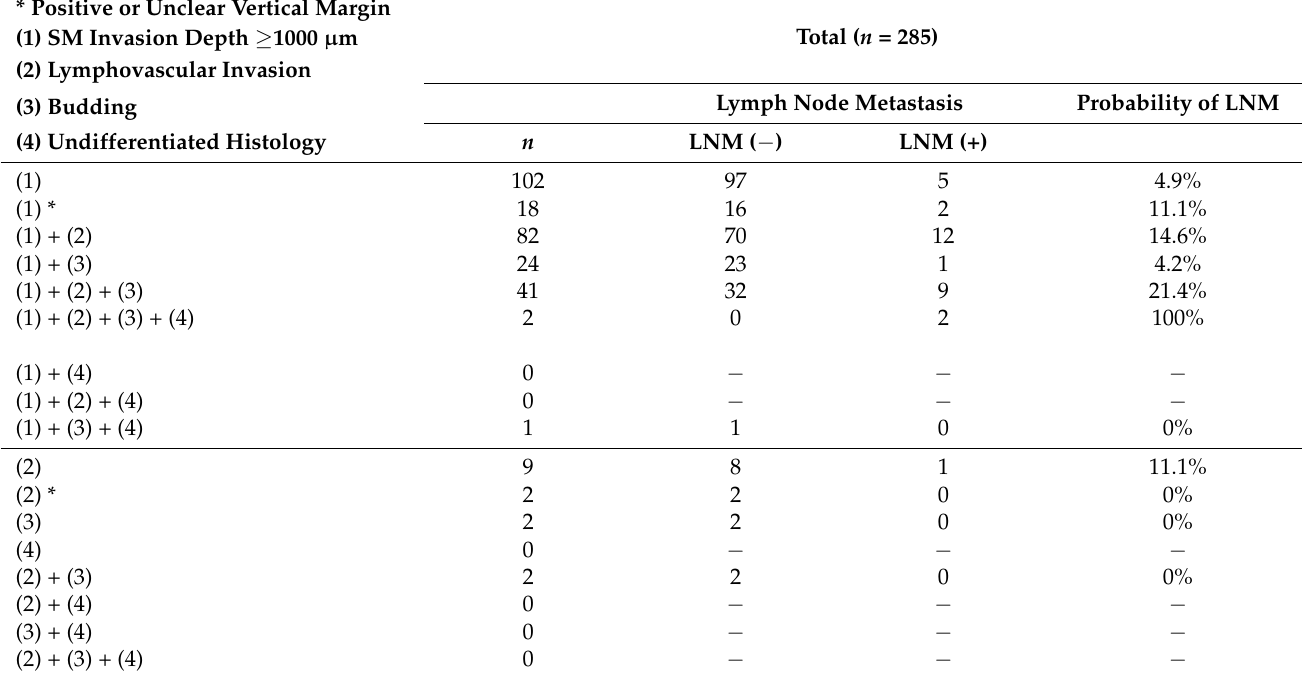
Table 3. According to the stratification of risk factors, incidence of lymph node metastasis in the high-risk